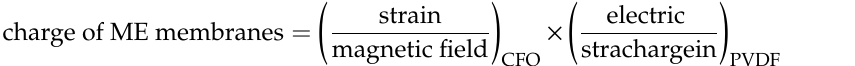
Figure 1d: (i) unpoled membranes under zero dc magnetic field, H dc = 0 Oe (membranes), (ii) unpoled membranes under a dc magnetic field of H dc = 700 Oe (membranes-DC), (iii) poled-membranes under zero dc magnetic field, H dc = 0 Oe (p-membranes), and (iv) poled-membranes under a dc magnetic field of H dc = 700 Oe (p-membranes-DC). Both e ff ects on the membrane surface charge were clearly revealed from comprehensive results illustrating active PM capture in the ME filtration